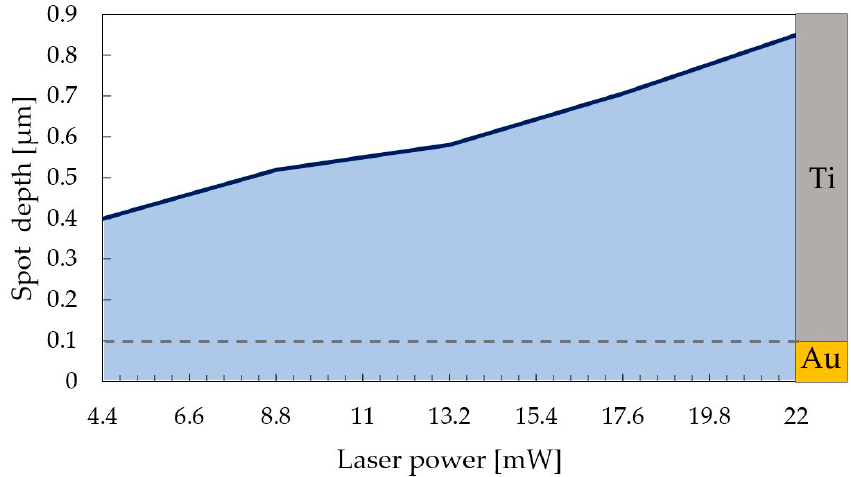
Figure 7. Laser power to spot depth diagram based on confocal results from single laser irradiation approach with visualization of coating thickness/depth ratio.